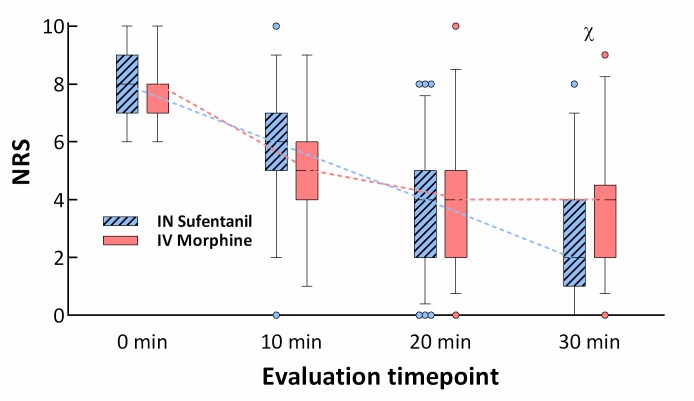
NRS at the different time points by group.The box extends from the 25th to the 75th percentile, and the whiskers are drawn down to the 5th percentile and up to the 95th. Points below and above the whiskers are drawn as individual points. No significant differences were observed in NRS values between groups at the 10-minute and 20-minute time points. IN sufentanil was non-inferior and superior to IV morphine in NRS reduction from drug administration to 30 minutes (NRST30 − NRST0). IN, intranasal; IV, intravenous; NRS, numerical pain rating scale.